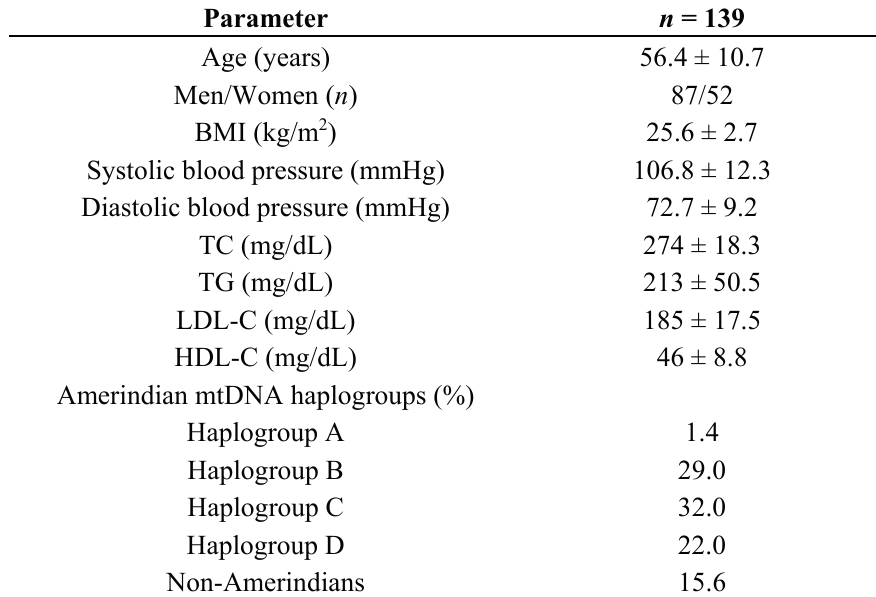
Table 1. Clinical and demographic characteristics of the study group.